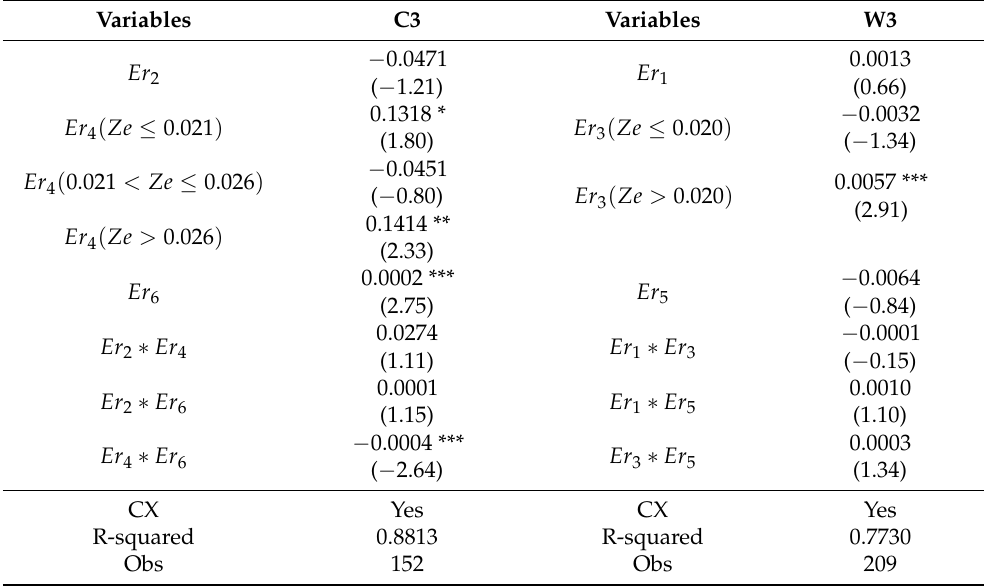
Table 12. Threshold regressions of market environmental regulations: central and western